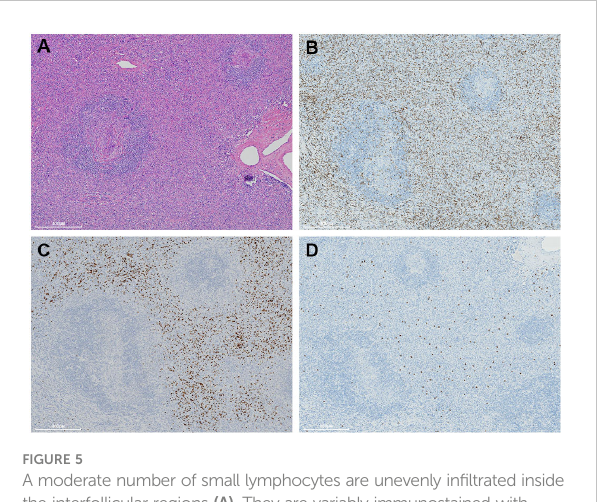
FIGURE 5 A moderate number of small lymphocytes are unevenly in fi ltrated inside the interfollicular regions (A) . They are variably immunostained with CD3 (B) , CD10 (C) , and TdT (D)